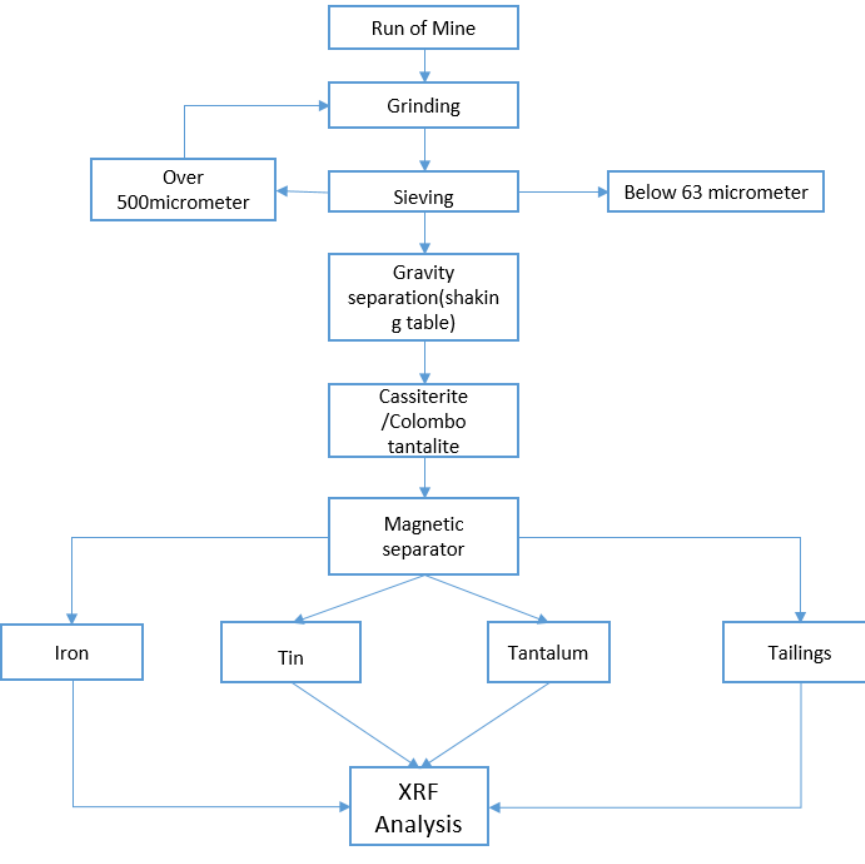
Figure 4. A flowchart showing the steps followed.